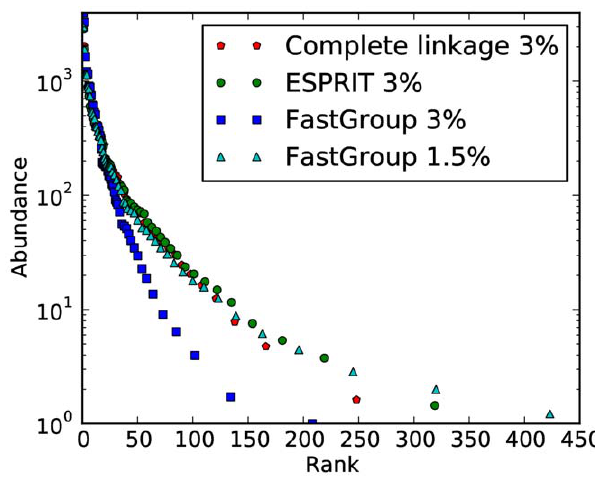
Figure 2. Rank abundance curves obtained with different algorithms and/or clustering distances. Notice that FastGroup with 1.5% sequence distance identifies a similar rank abundance curve to those of ESPRIT and complete linkage. However, it is not evident from the Figure that FastGroup identifies almost two times the number of OTUs than ESPRIT or complete linkage.